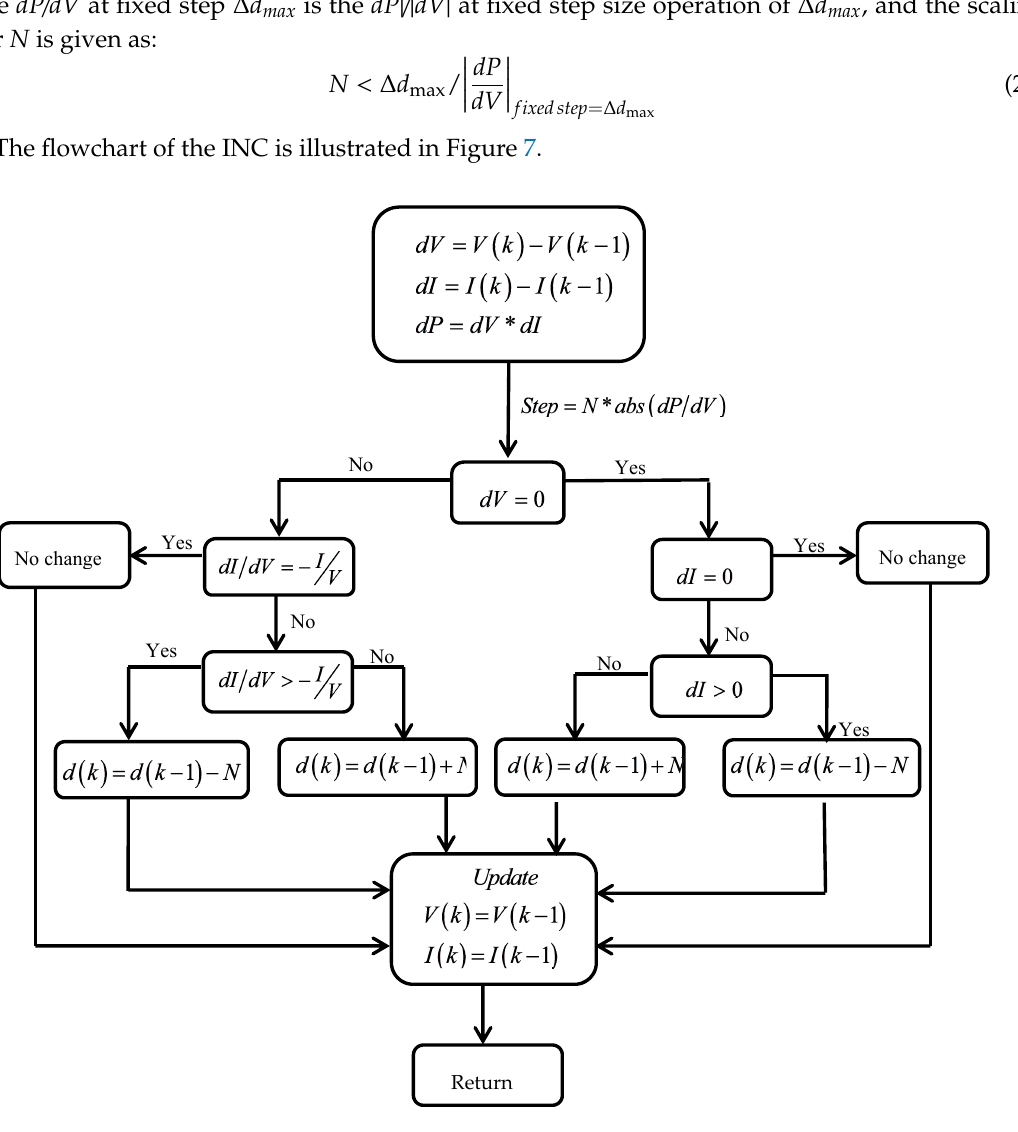
Figure 7. Flowchart of incremental conductance (INC) algorithm.